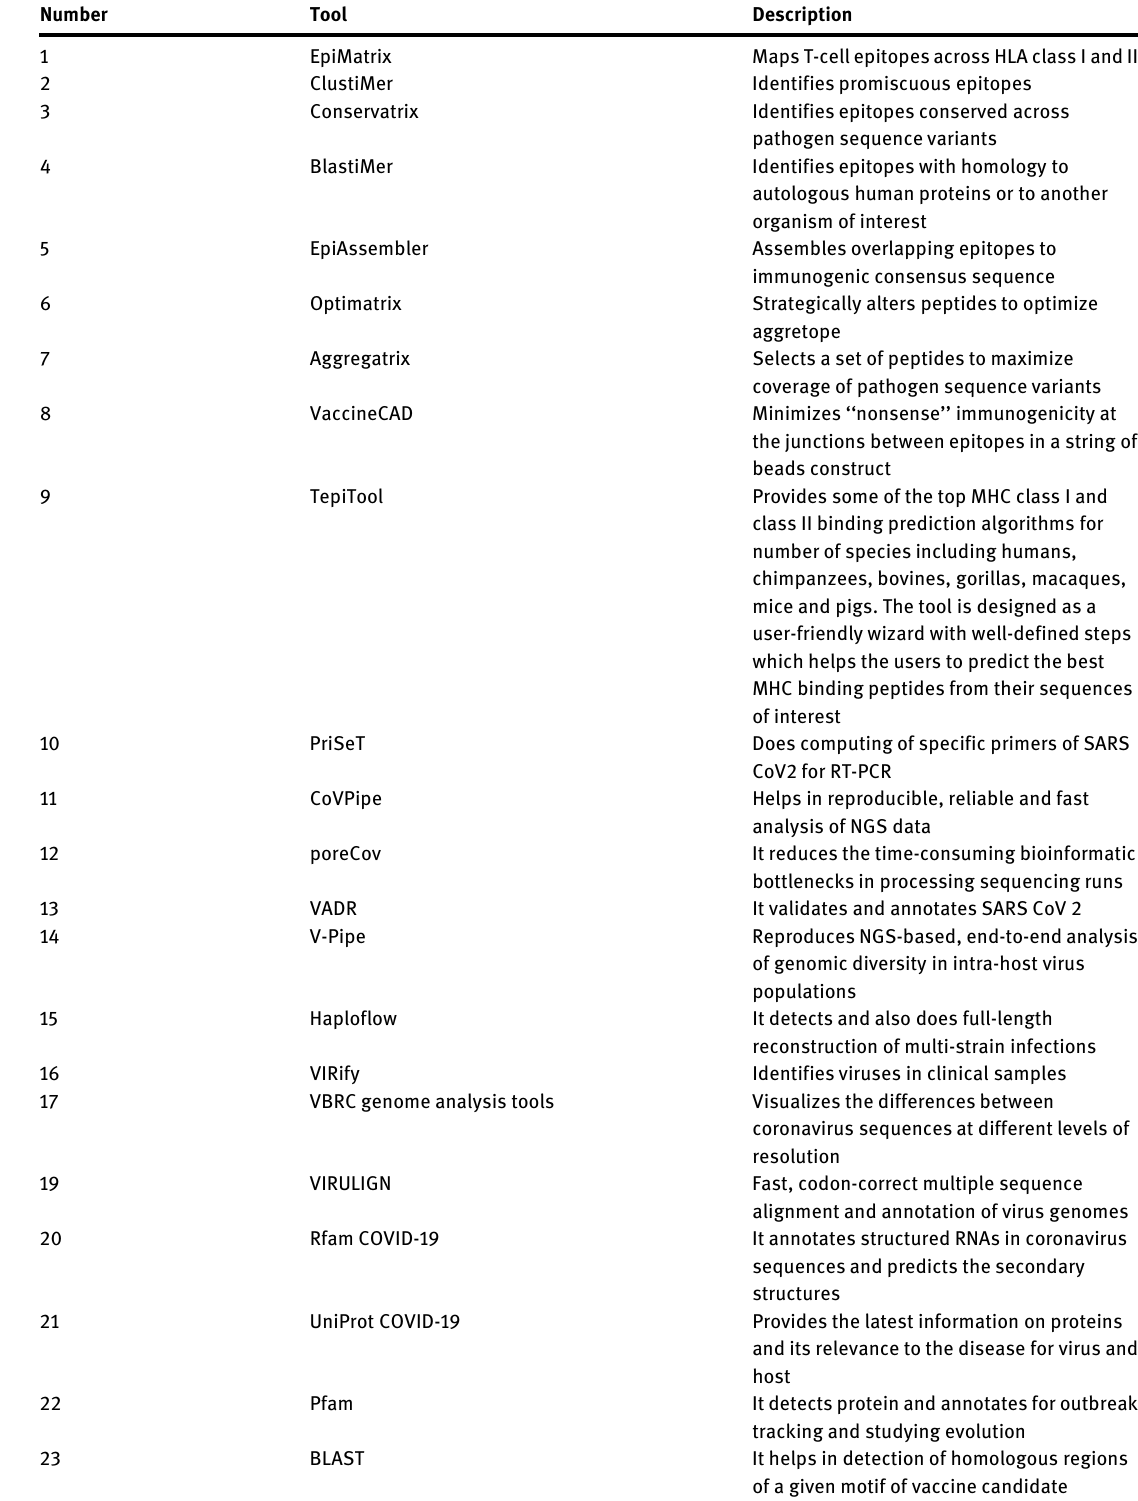
Table 2: Bioinformatics tools for COVID-19 vaccine development used in the computational analyses, reduced from focused reviews [ 19, 20